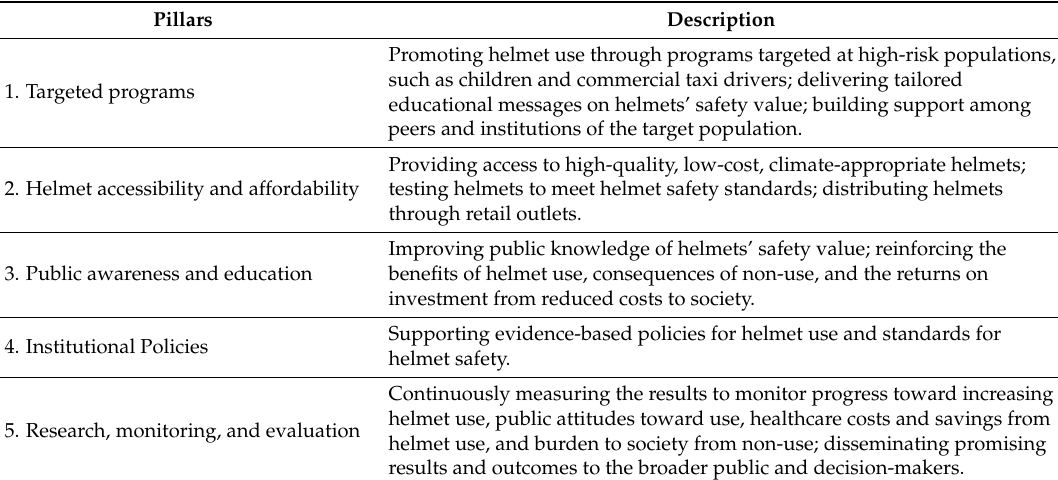
Table 1. Five pillars of the Global Helmet Vaccine